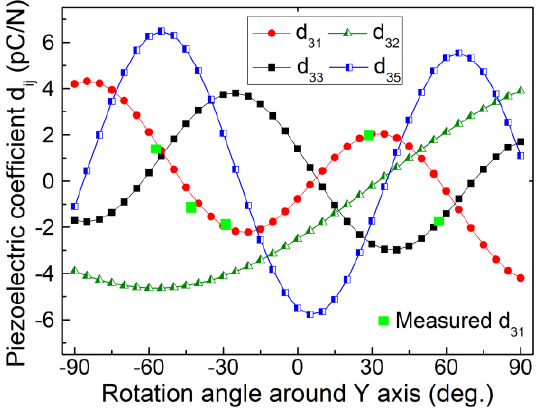
Figure 7. Variations of piezoelectric coefficients d rotation angle around the Y -axis. Reprinted with permission from [57]. Copyright 2014